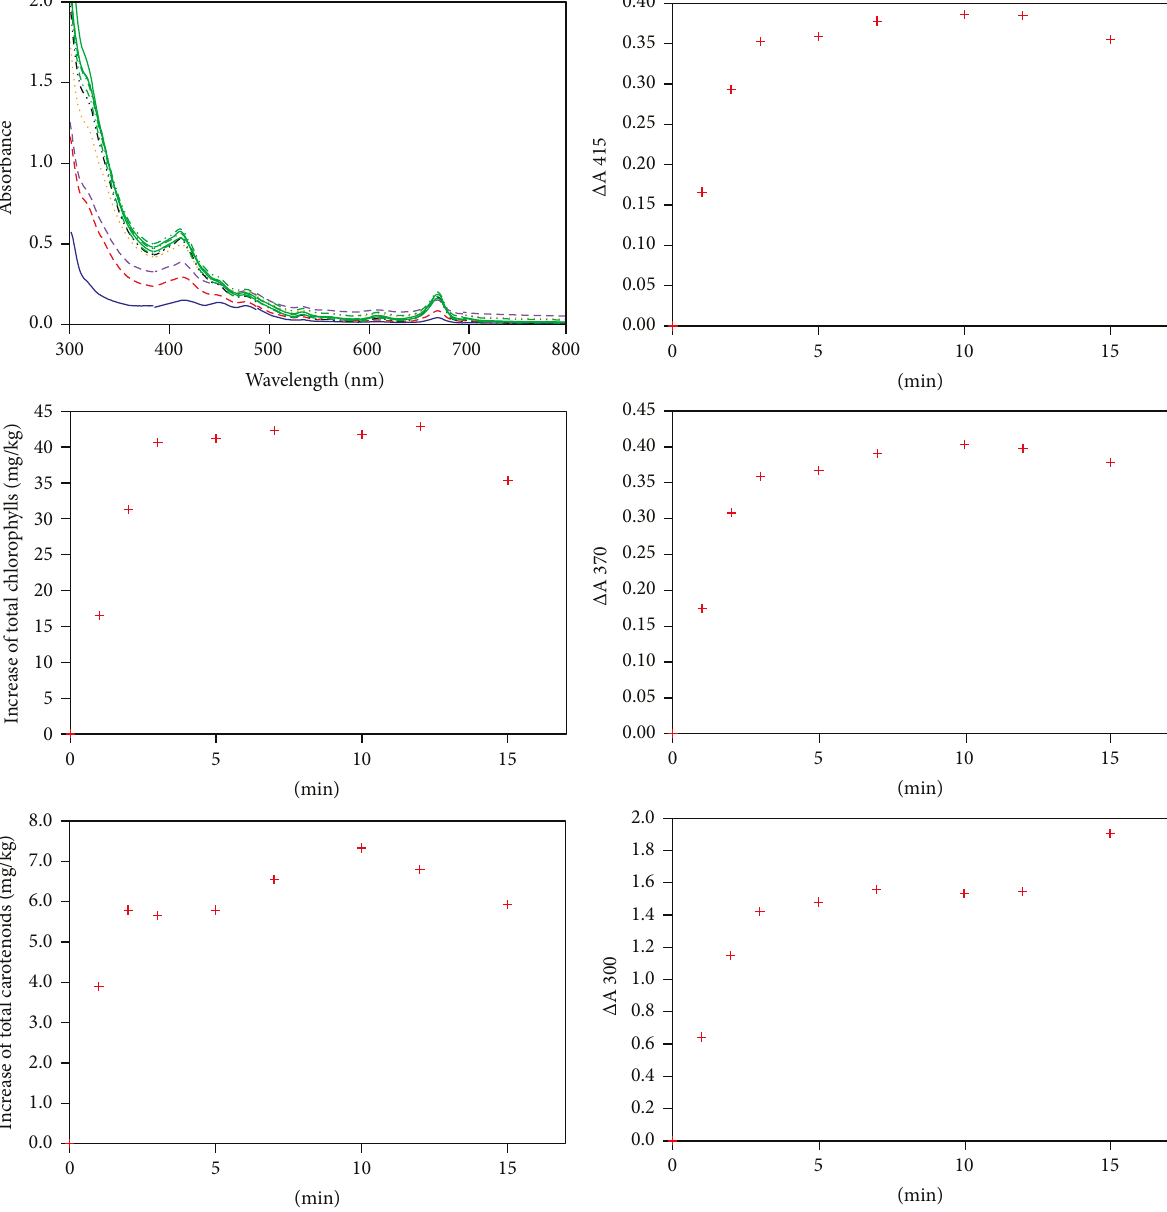
Figure 4: Garden sage ultrasound maceration, results of UV-Vis measurements. For comparison, the results for 20 hours of conventional maceration are as follows: increase in chlorophylls, 11.4 mg; increase in carotenoids, 1.9mg; Δ A 415, 0.124; Δ A 370, 0.128; and Δ A 300,